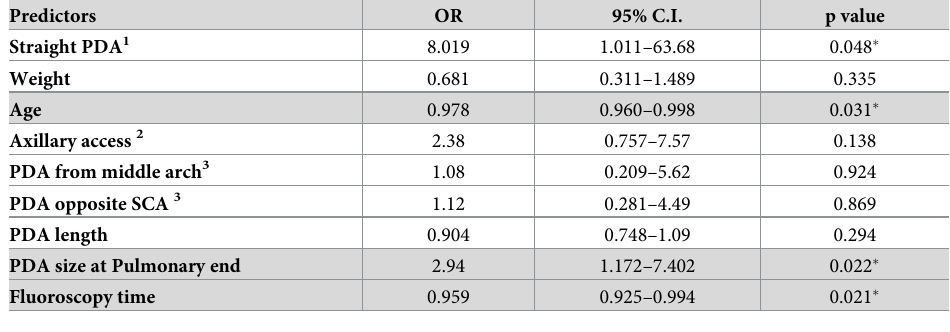
Table 3. Indicators of success for PDA